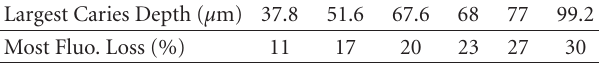
Table 1: List of data for building statistical linear regression model. Largest Caries Depth ( μ m)